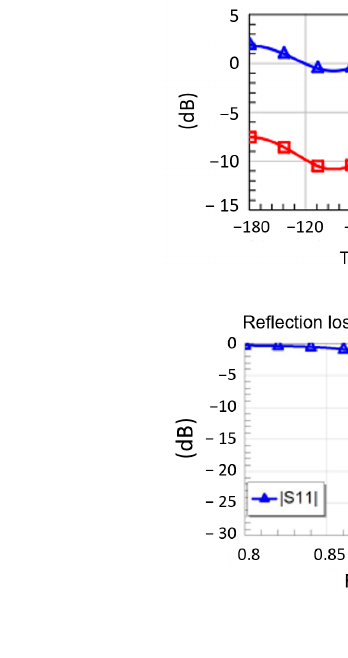
Figure 5. ( a ) The electromagnetic design of the RFID antenna integrated in the multilayer structure from Figure 1; ( b ) comparison between the gain at 915 MHz of the antenna in free space and the integrated antenna; ( c ) the adaptation circuit and ( d ) circuit simulations of the antenna integrated with the chip.